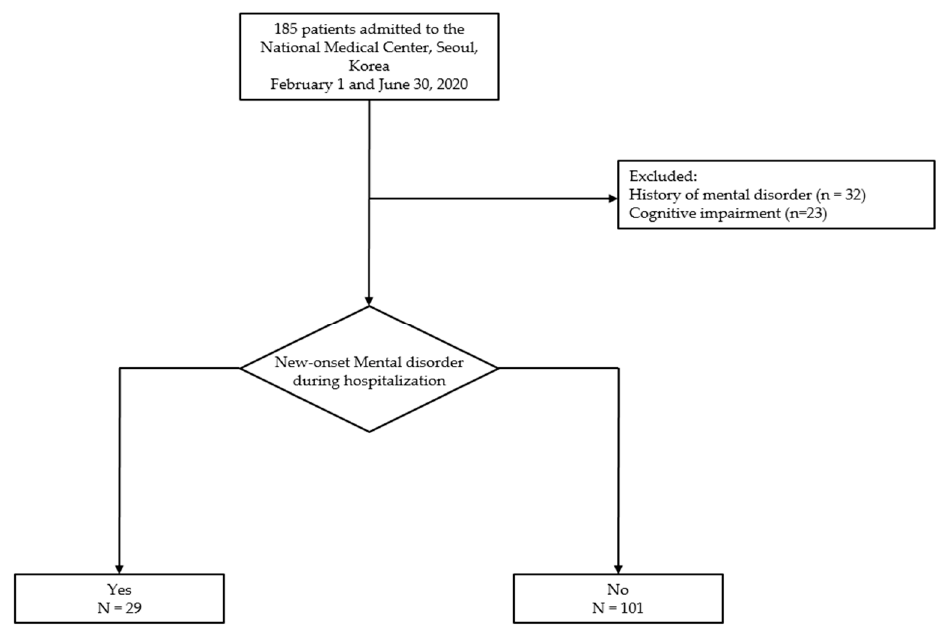
Figure 1. Flow chart of patients with COVID-19 admitted to the National Medical Center